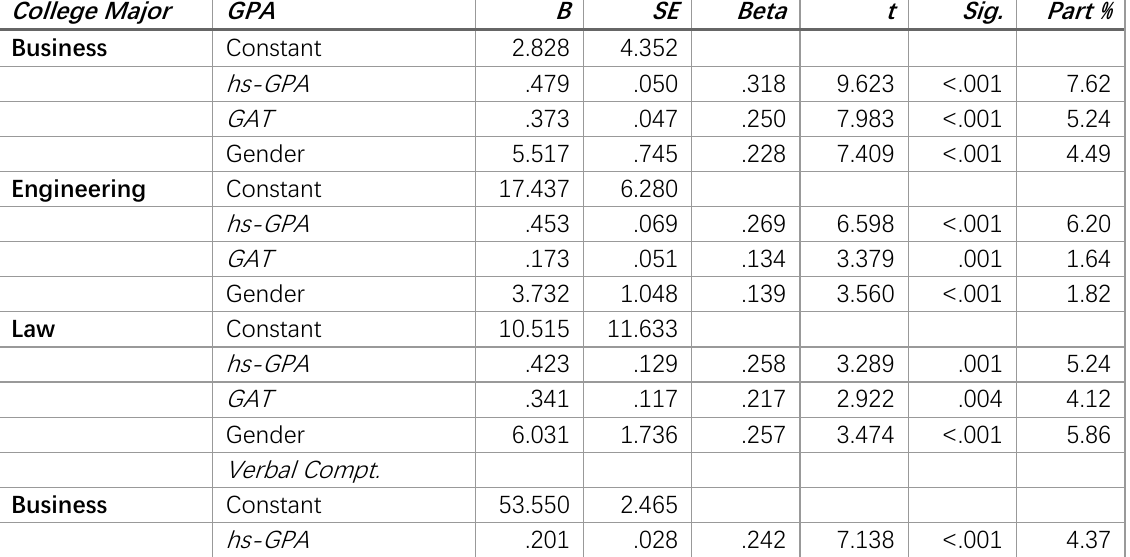
Table 3: Regression Analyses College